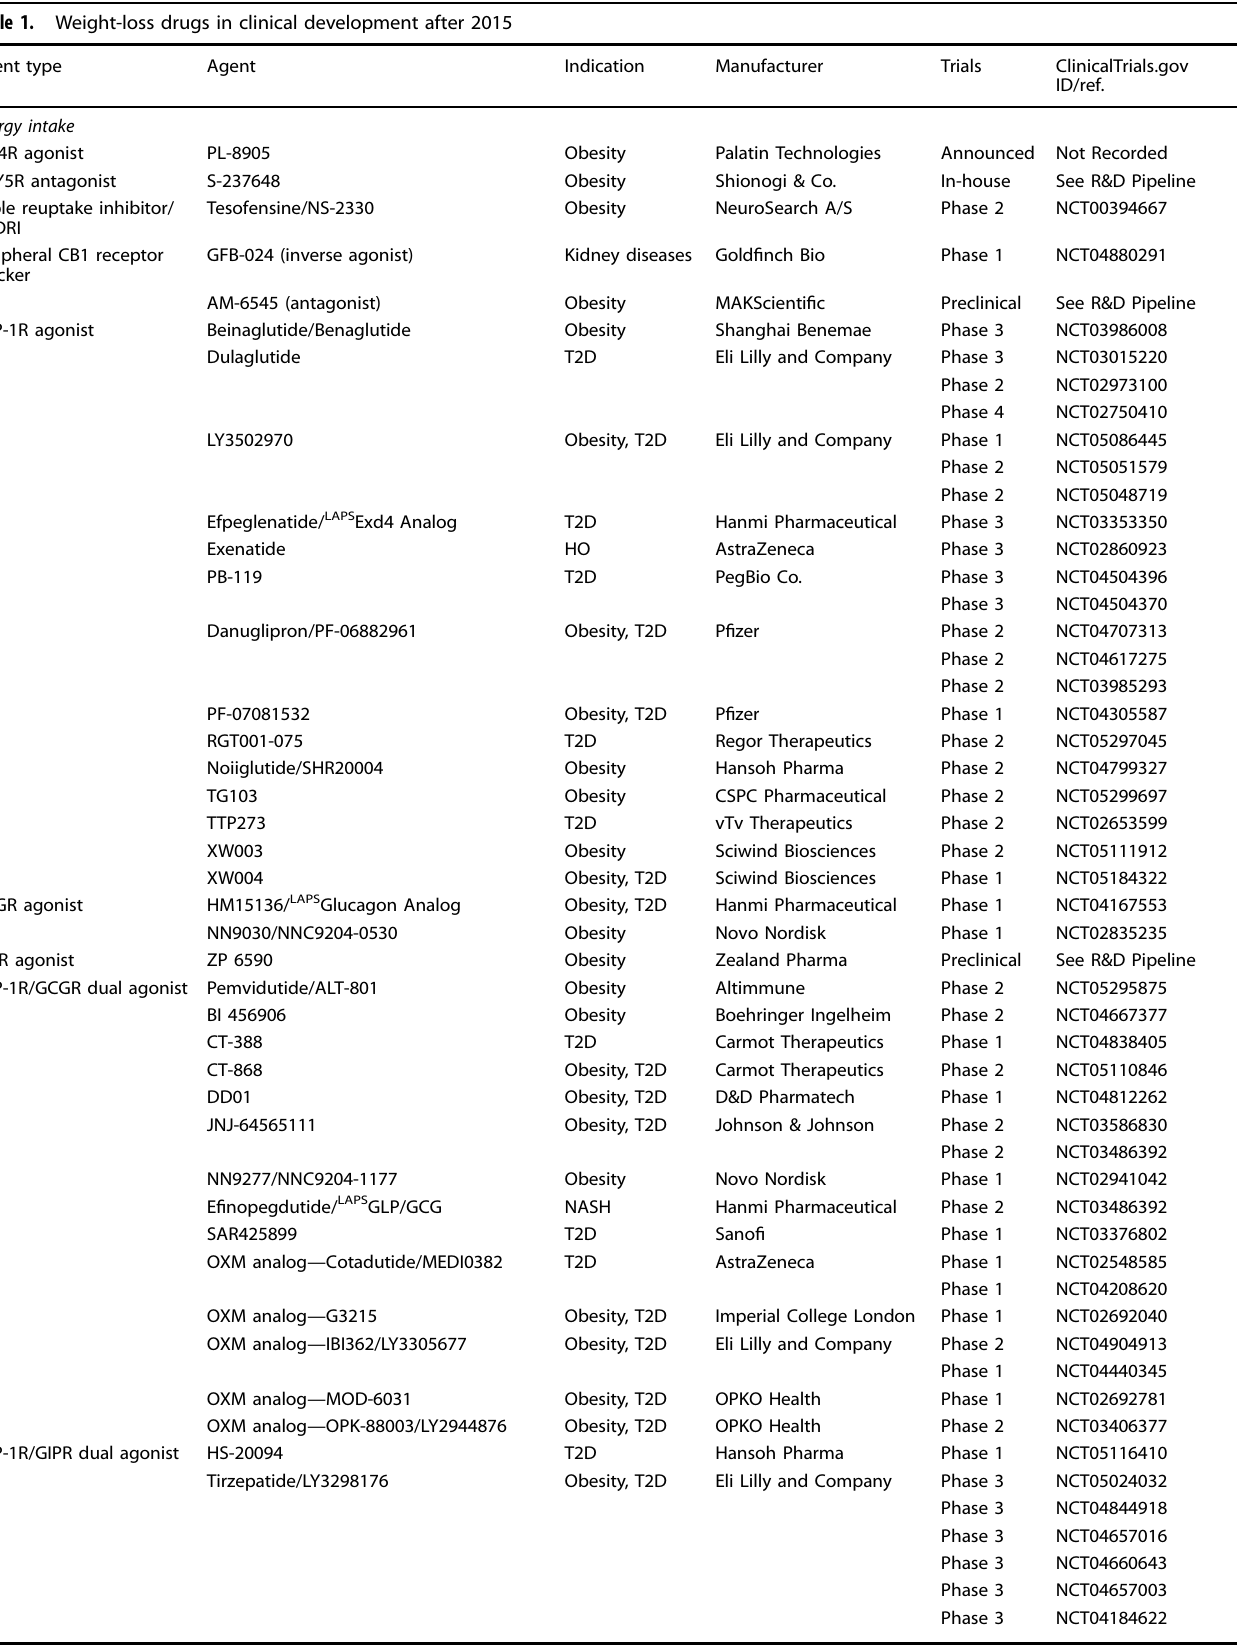
Table 1. Weight-loss drugs in clinical development after